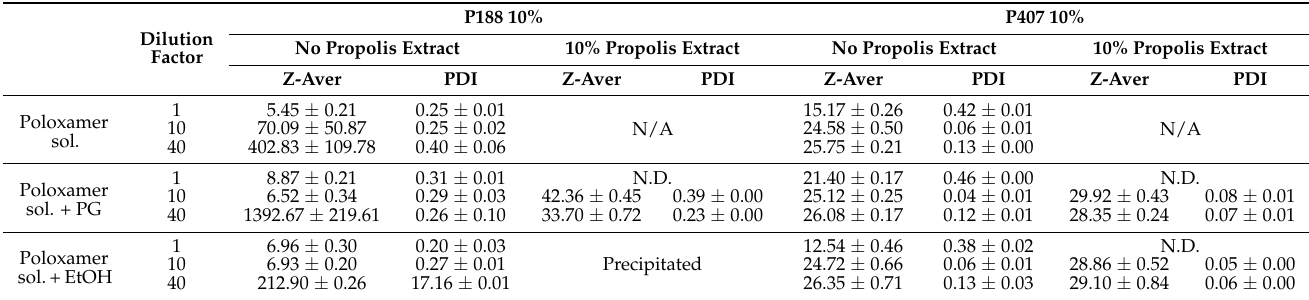
Table 3. Z-average micelle size and PDI of various formulations determined by DLS ( n = 3). Poloxamer Dilution Factor